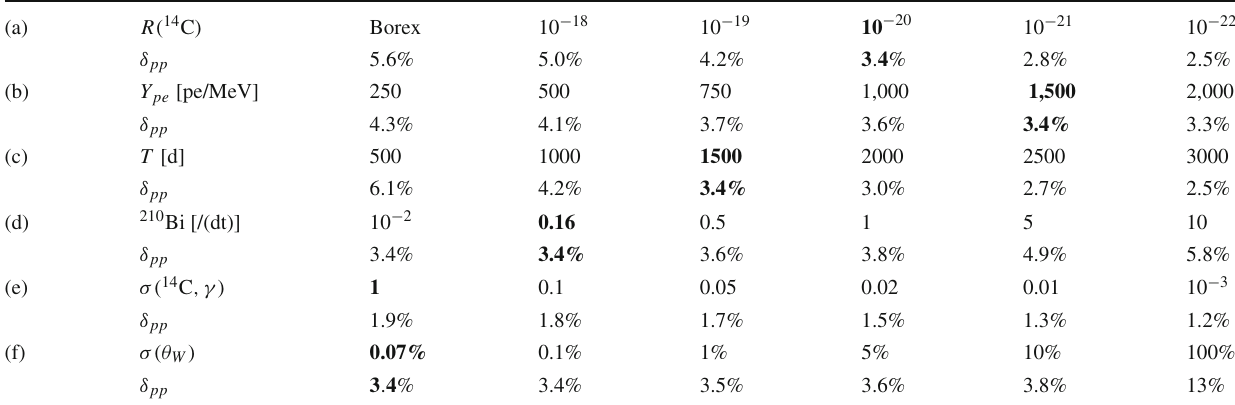
Table 4 Dependence of the relative pp flux uncertainty measured by Serappis, δ pp , on (a) the 14 C content of the scintillator, (b) the photo electron yield, (c) the measuring time T , and (d) the level of internal 210 Bibackground.Allotherparametersarekeptaccordingtothedefault scenario.Forrow(e), R = 10 − 22 , Y pe = 2000pe/MeVand T =